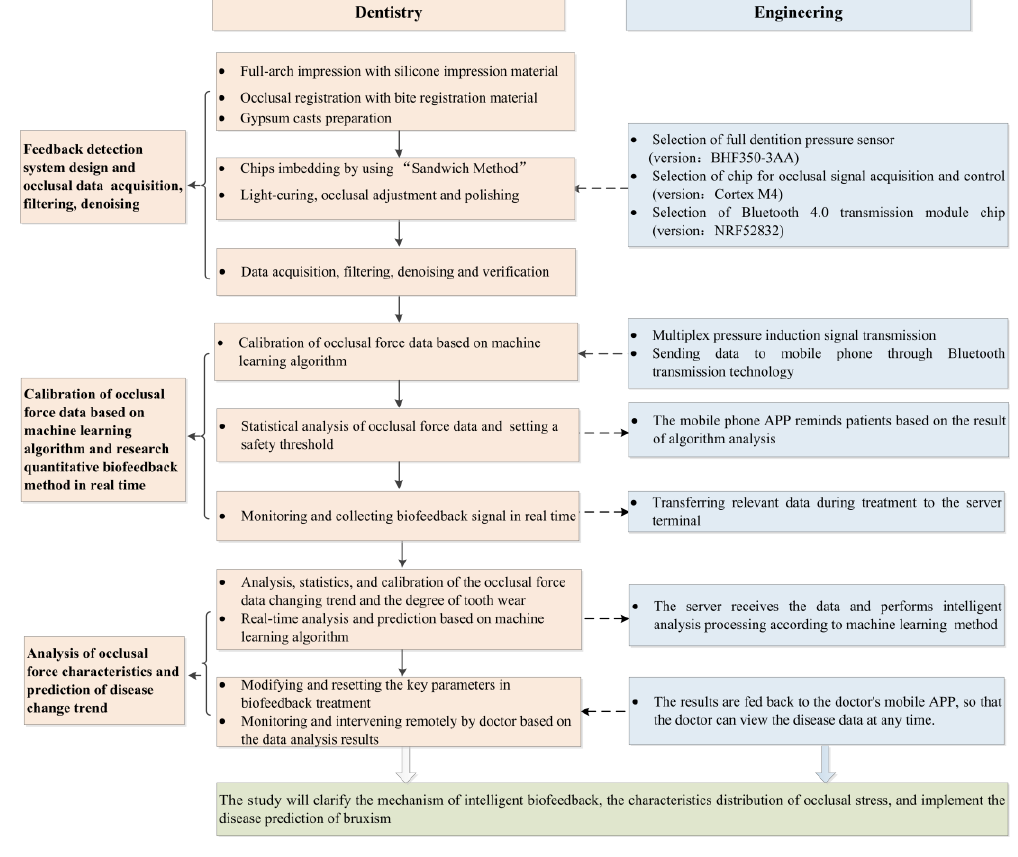
Figure 1. Overall illustration of the interdisciplinary research and three main contributions of this study.